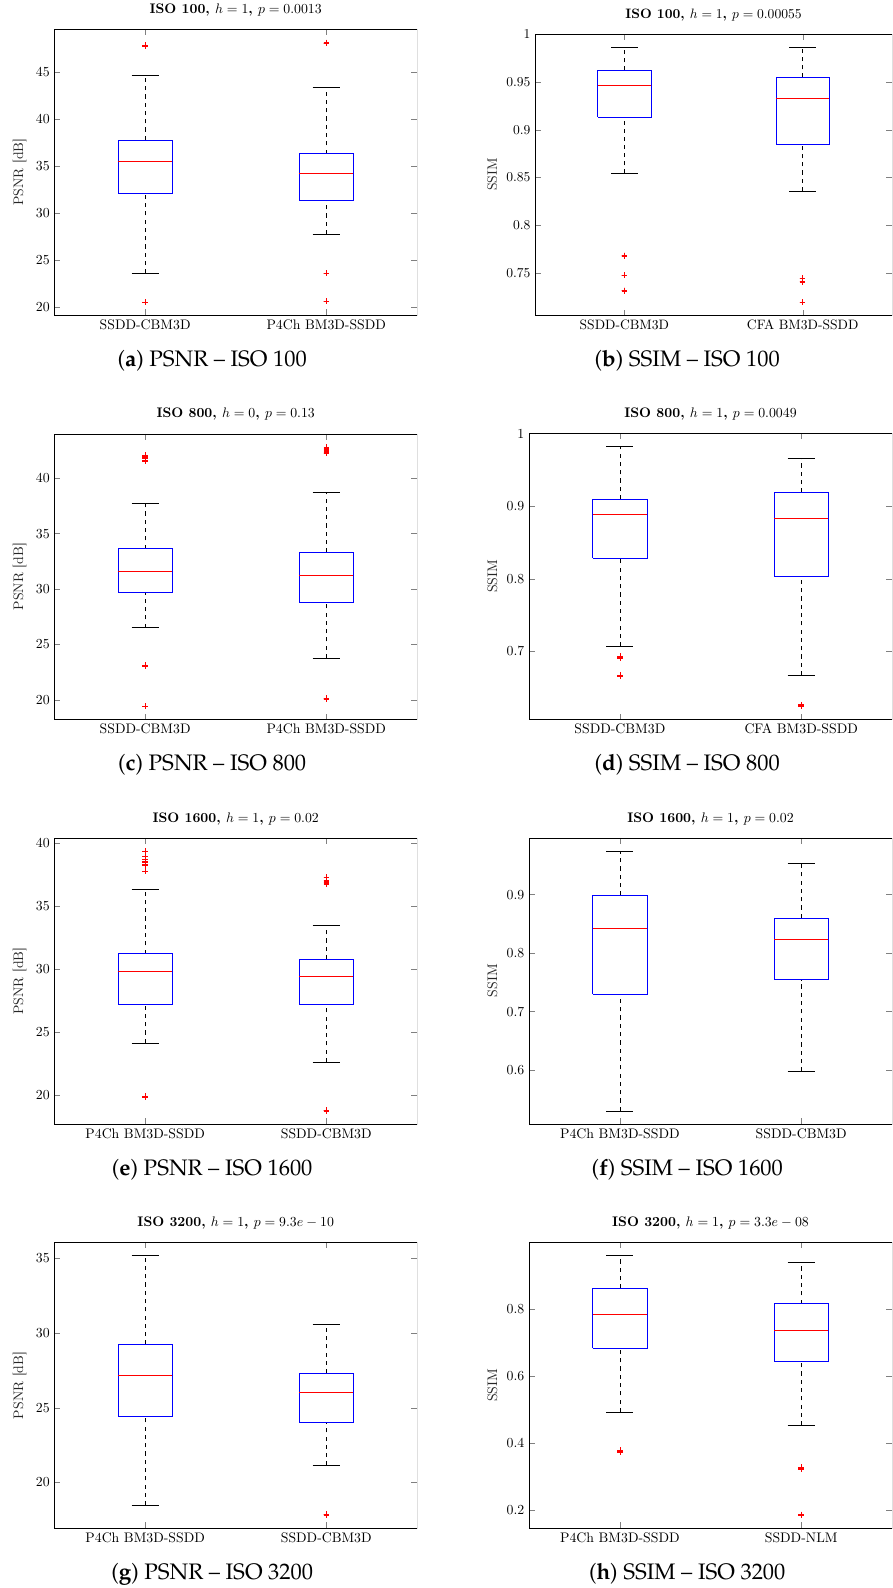
Figure 19. Pairwise comparison of different filtering approaches - grouped by ISO